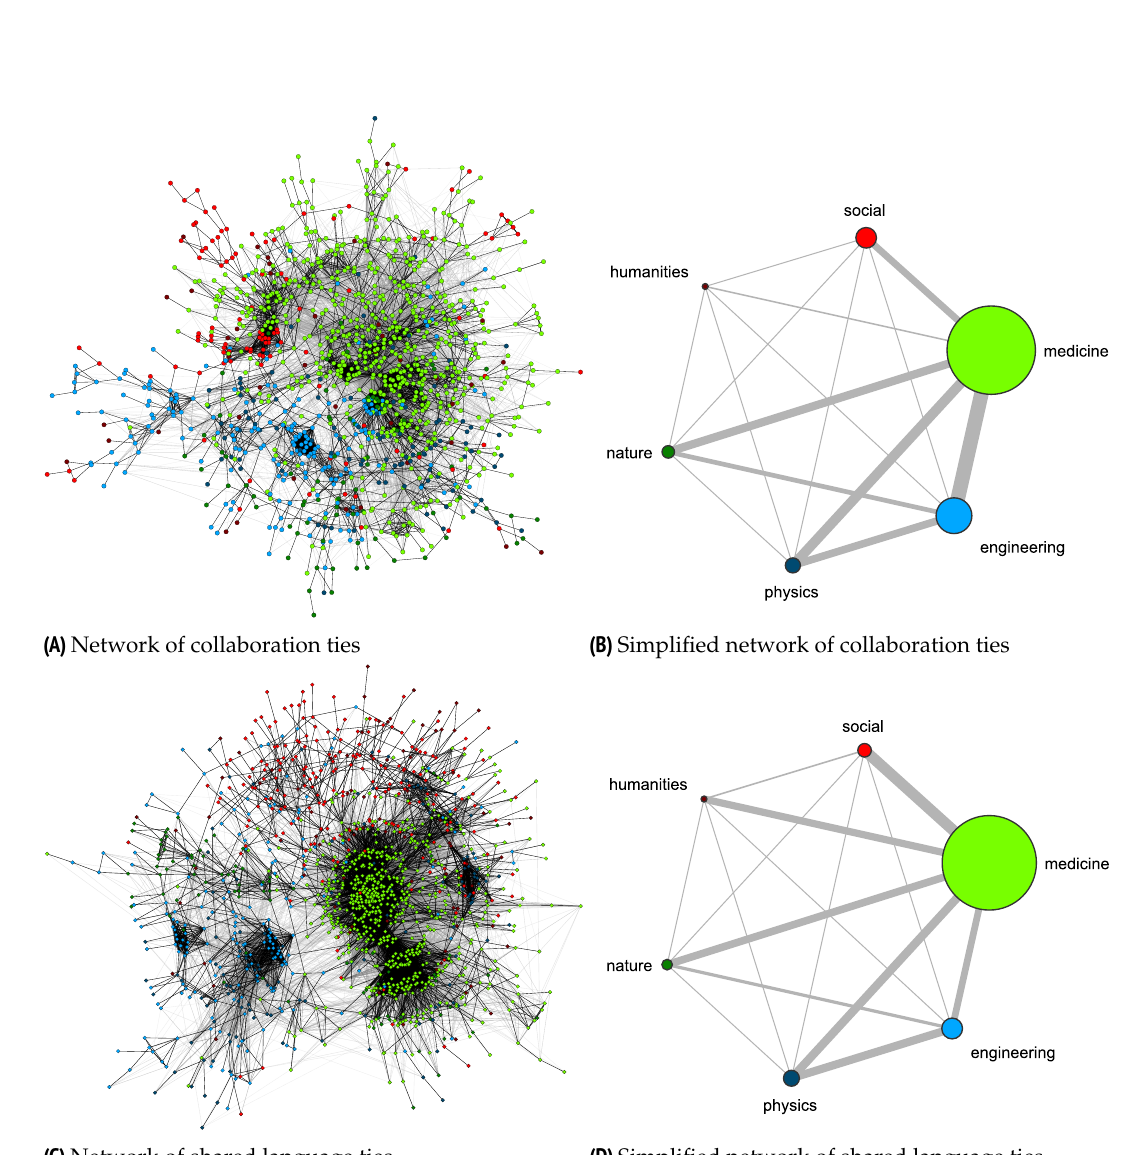
Figure 1: Illustration of collaboration and shared language networks in the period 1998 to 2001. Notes : ( A ) The network consisting of collaboration ties ( n = 8, 280) in the period between 1998 and 2001 among all faculty ( n = 1, 214) who belong to the core network (referring to faculty with at least one tie to the large structure; n = 709 excluded). ( B ) A simplified version of complete network in panel ( A ). ( C ) A network consisting of shared language ties ( n = 20, 848) in the period between 1998 and 2001 among all faculty ( n = 1, 385) who belong to the core network (referring to faculty with at least one tie to the large structure; n = 538 excluded). ( D ) A simplified version of the complete network shown in panel ( C ). Larger nodes in panels ( B ) and ( D ) have more within-discipline ties, and thicker lines have more between-discipline